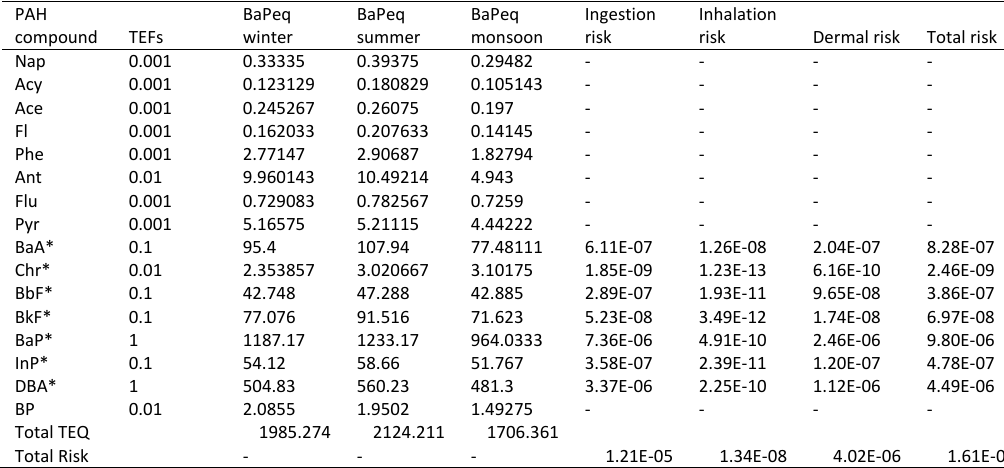
Table 4: Toxic equivalent concentration (BaPeq) and cancer risk